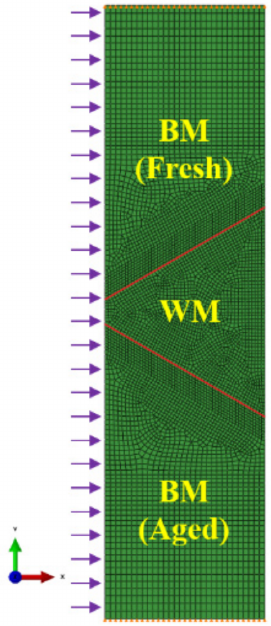
Figure 12. FE model and element division of the welded